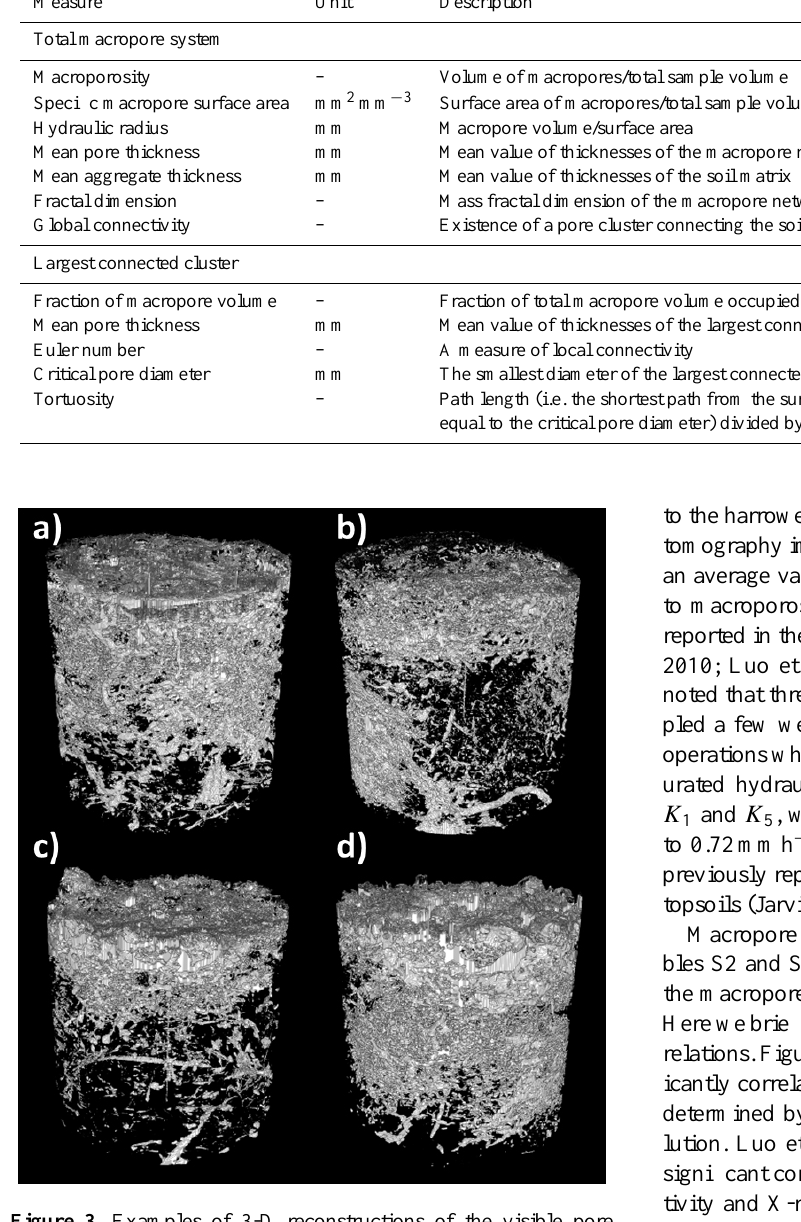
Figure 3. Examples of 3-D reconstructions of the visible pore space (a) Säby 1 (loam), (b) Säby 2 (clay), (c) Ultuna (clay) and (d) Krusenberg (clay loam). The columns were 20cm in diameter and between 15 and 18.3cm